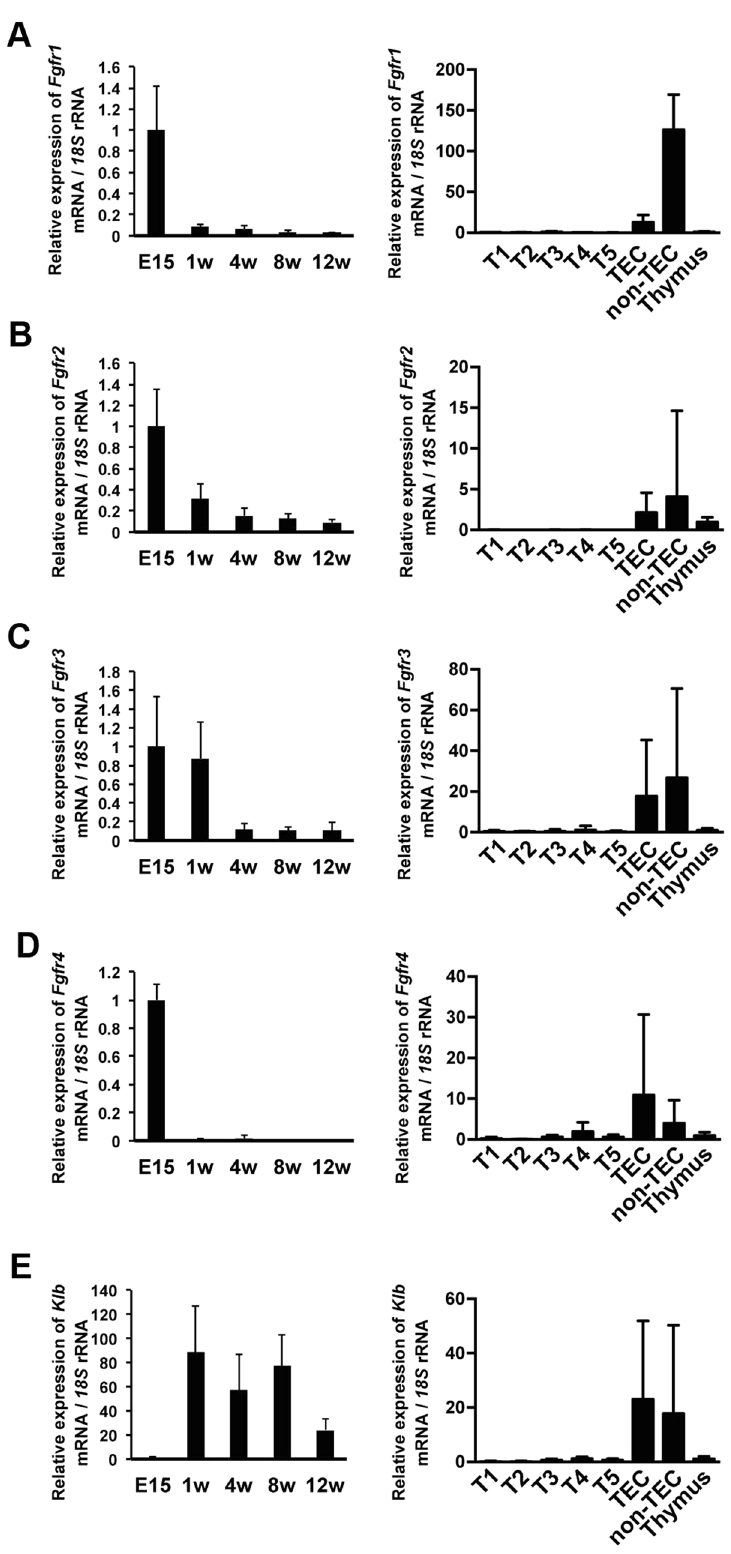
Figure 3. Fgfr and Klb are highly expressed in thymic stromal cells. ( A–E ) Relative mRNA expression of Fgfr1 ( A ), Fgfr2 ( B ), Fgfr3 ( C ), Fgfr4 ( D ), and Klb ( E ) in the thymus of E15.5 and 1-, 4-, 8- and 12-week-old (left panels), and in thymocyte subpopulations (T1-T5), TECs (CD45 − EpCAM + ), and non-TEC stromal cells (CD45 − EpCAM − ) of 4-week-old C57BL/6 mice (right panels). Graphs represent the mean ± SD; n ≧ 5 replicates per group from at least 3 independent